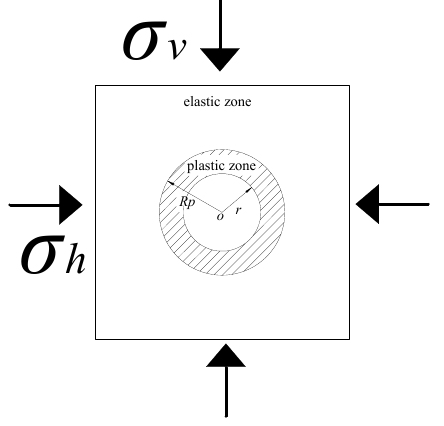
Figure 13. Plastic zone of circular tunnel.